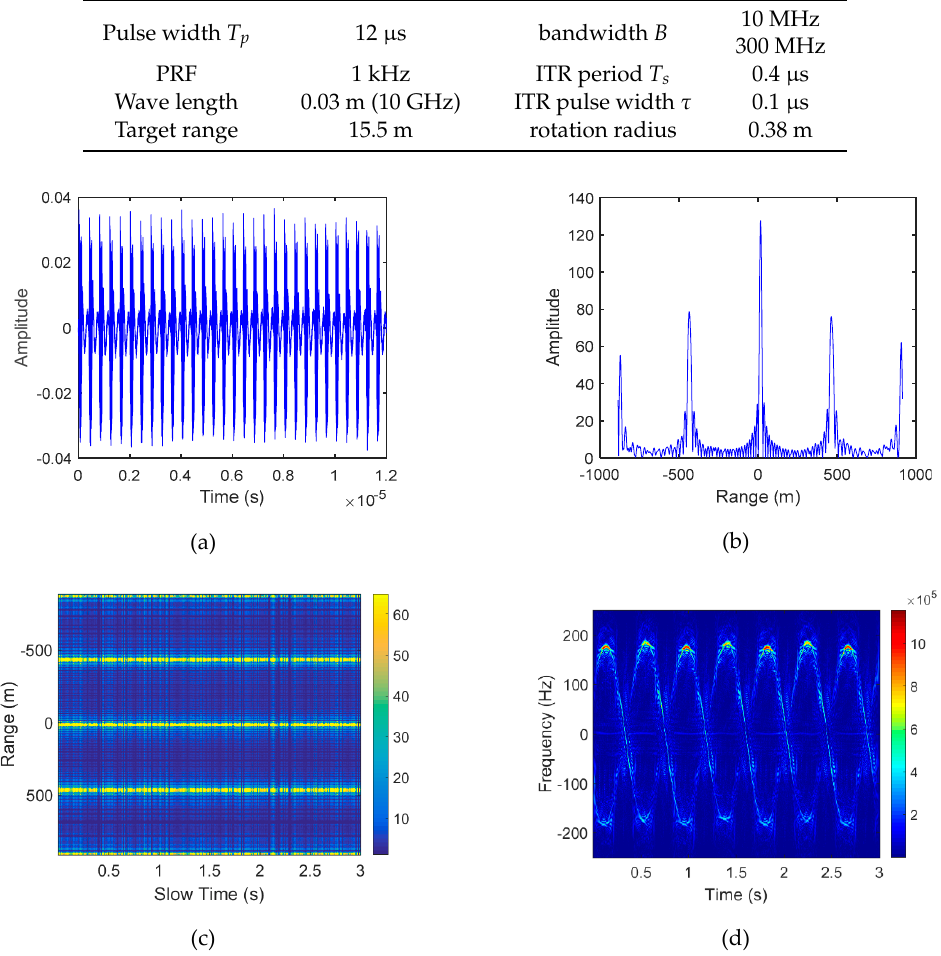
Figure 6. ITR echo and the micro-Doppler extraction results (B = 10 MHz). ( a ) ITR echo. ( b ) HRRP of the ITR echo. ( c )Range slow-time image. ( d ) Time-frequency image.